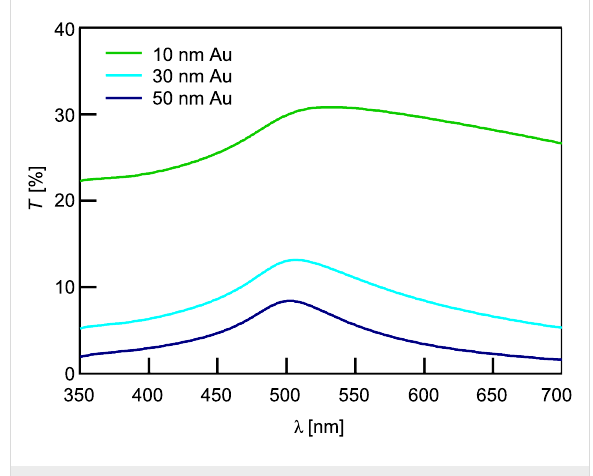
Figure 2: UV–vis spectra of Au/glass substrates with Au layer thick- nesses of 10 nm, 30 nm and 50 nm.